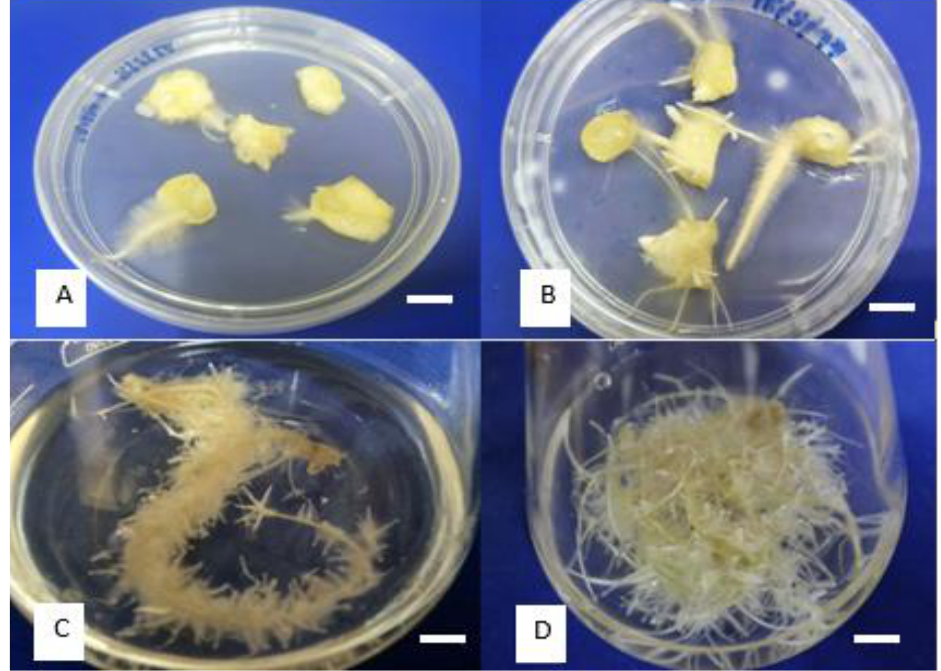
Figure 3. Establishment of AdRC of Z. zerumbet. ( A ) Root induction in control treatment; ( B ) root induction in MS medium supplemented with 1 mg/L NAA and 2 mg/L IBA; ( C ) multiplication of AdRC in MS medium supplemented with 1 mg/L NAA and 3 mg/L BAP after 5 days in shake flask; ( D ) multiplication of AdRC in MS medium supplemented with 1 mg/L NAA and 3 mg/L BAP after 15 days in shake flask. Bar: 0.5 cm